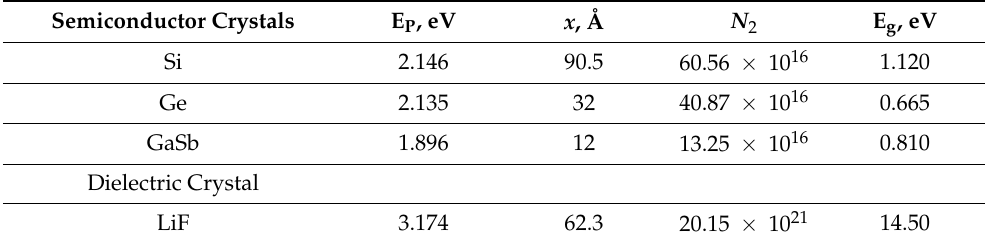
Table 4. Results of quantitative calculations of the characteristics of surface plasmons for crystalline crystalline semiconductors and